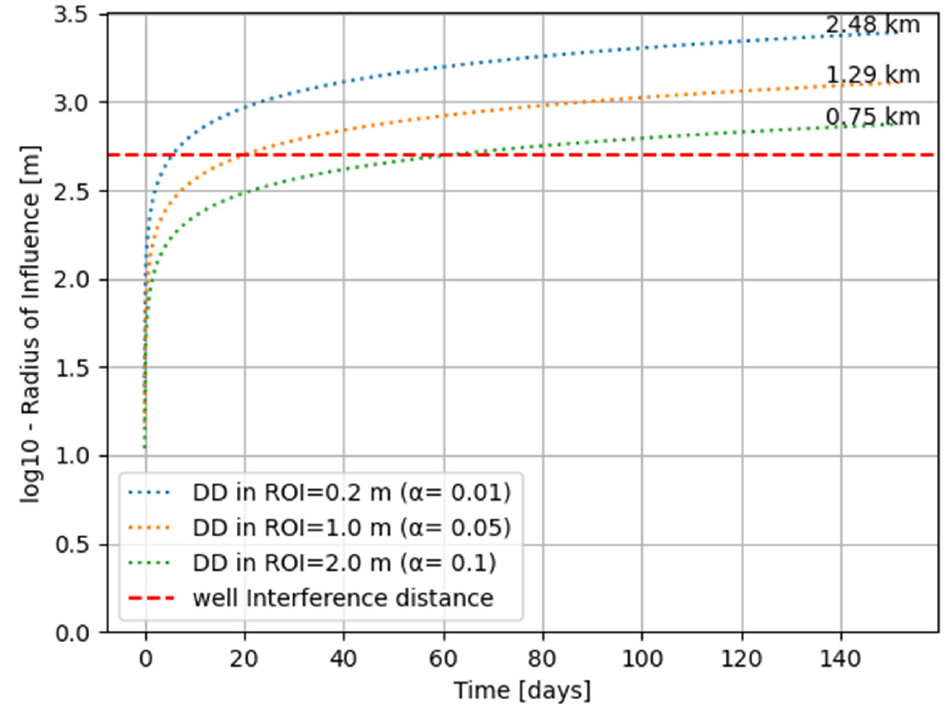
Figure 7. The application of the RBT for defining the ROI of the hypothetical well north of Wadi Al Arab 4.